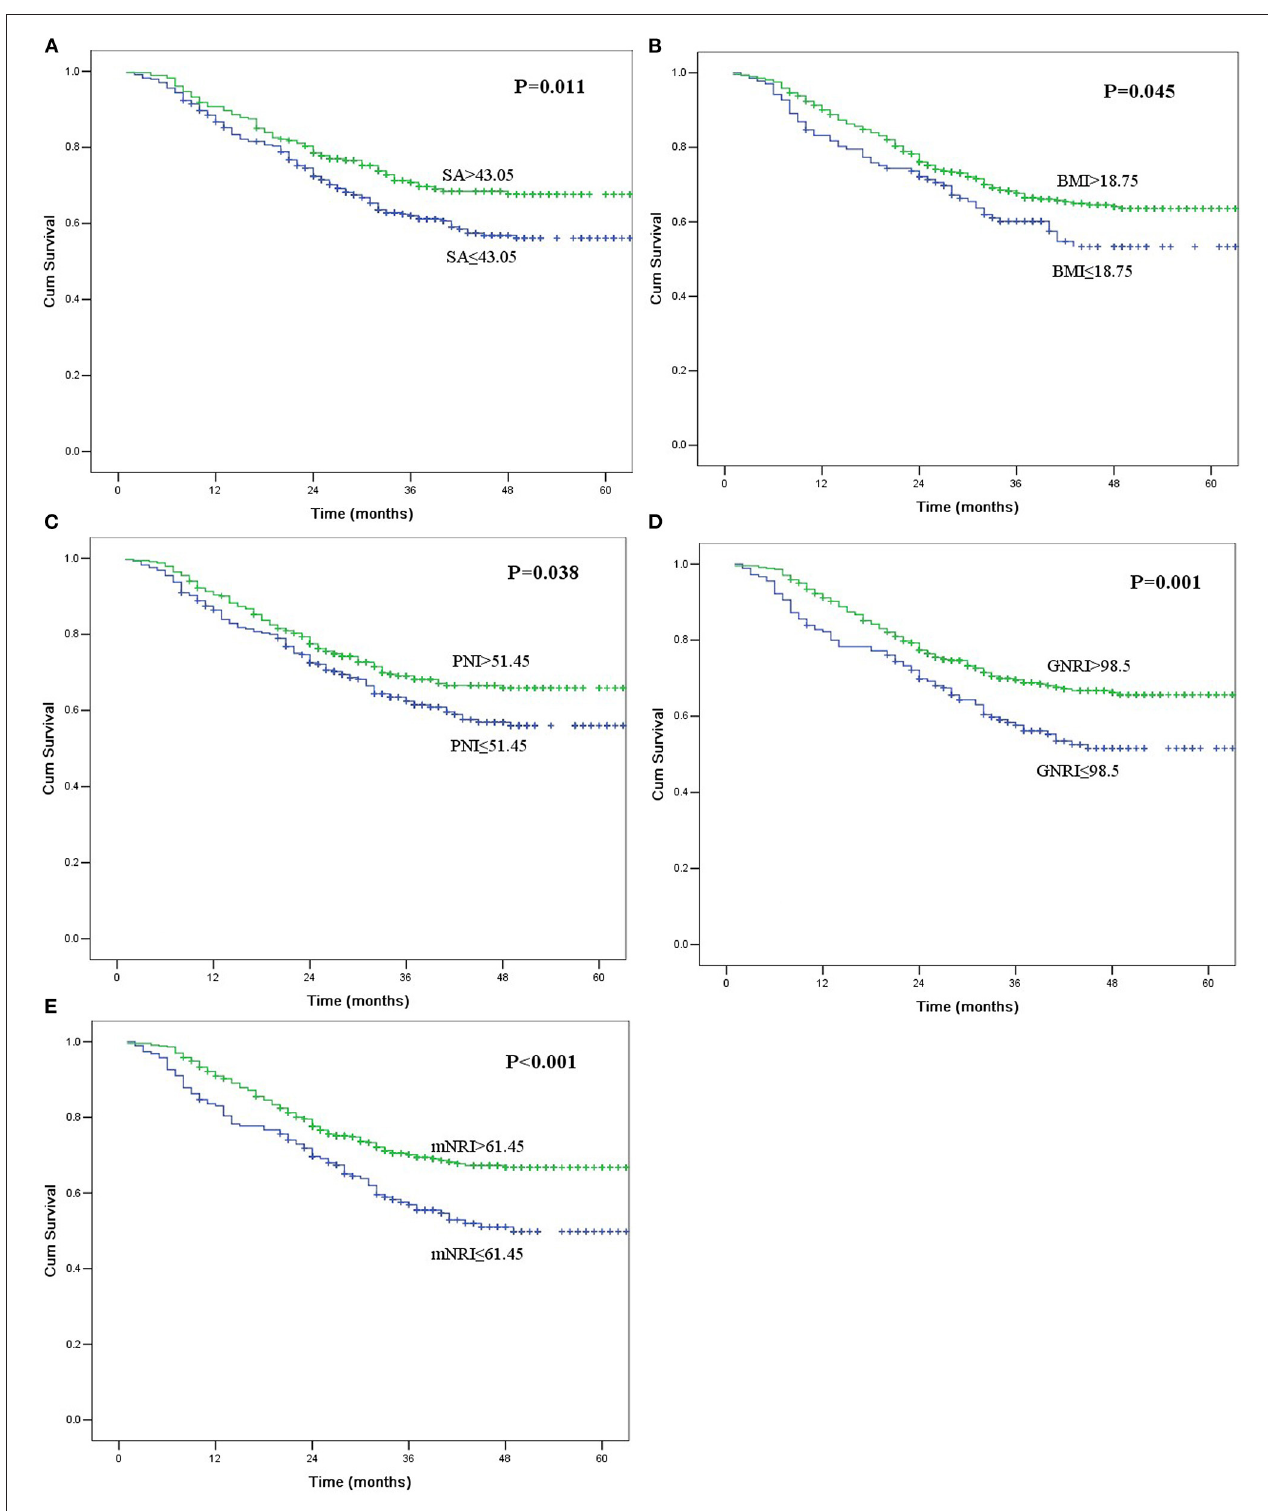
FIGURE 1 | Kaplan-Meier curves for overall survival according to serum albumin (SA, A ), body mass index (BMI, B ), prognostic nutritional index (PNI, C ), geriatric nutritional risk index (GNRI, D ), and modified nutritional risk index (mNRI, E ). All of the survival differences were significant ( P < 0.05).